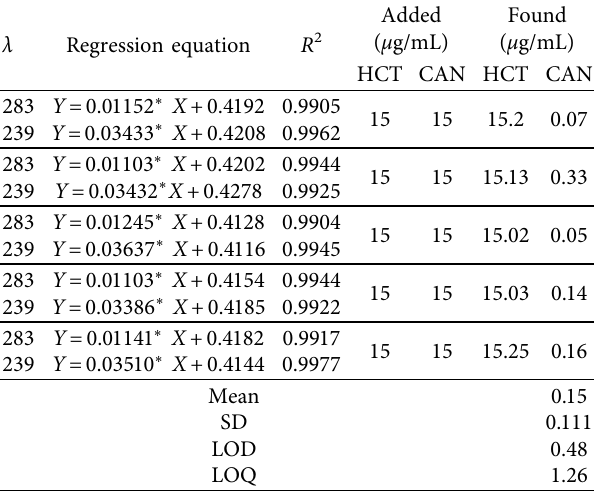
Table 3: Limit of detection (LOD) and limit of quantifcation (LOQ) of CAN by HPSAM.